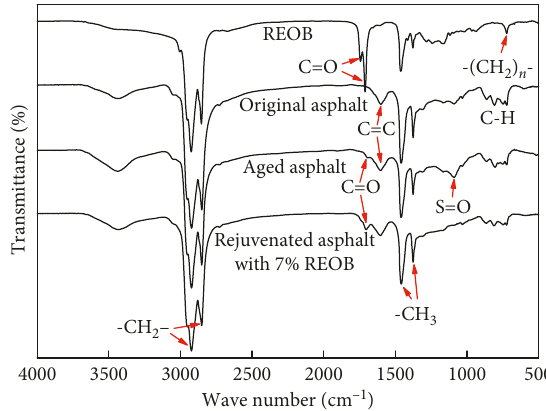
Figure 6: Infrared spectrograms of REOB and asphalt